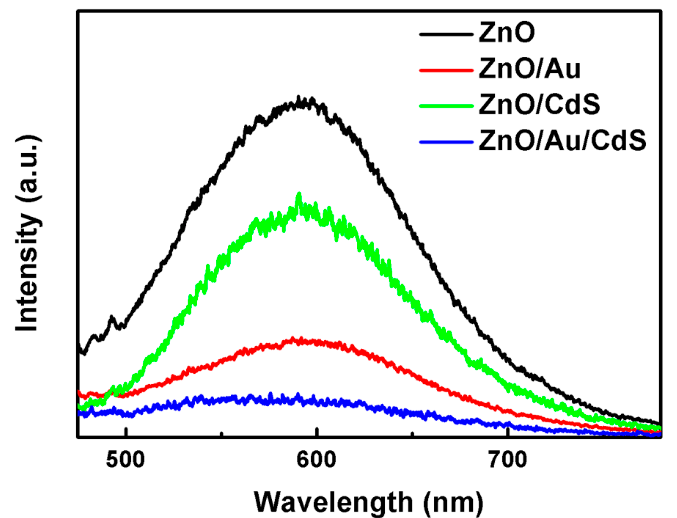
Figure 7. Photoluminescence (PL) spectra of ZnO, ZnO/Au, ZnO/CdS and ZnO/Au/CdS samples. The ZnO, ZnO/Au, ZnO/CdS and ZnO/Au/CdS samples are used for photocatalytic water splitting for H 2 evolution. As shown in Figure 8a, both ZnO and ZnO/Au samples present low gas evolution rates of 22.3 and 33.5 µ mol/g/h, respectively. The ZnO/CdS sample shows a much higher gas evolution rate of 346.0 µ mol/g/h, which can be ascribed to the formation of type II heterojunction structure and the extension of light absorption range. After the introduction of Au nanoparticles into the ZnO/CdS system, the ZnO/Au/CdS ternary composite photocatalyst sample shows a remarkably improved photocatalytic performance with a gas evolution rate of 502.2 µ mol/g/h, which is about 1.5 times than that of ZnO/CdS sample. The results suggest that the Au and CdS nanoparticles have a synergistic effect for the improvement of photocatalytic water splitting. Meanwhile, in order to prove the stability of the ZnO/Au/CdS ternary composite photocatalyst, the cycling stability measurement is conducted. As shown in Figure 8b, the amounts of gas evolution maintain for four cycles with slight decay and the slight decrease in photocatalytic activity is attributed to the ZnO photocorrosion phenomena [23,53]. The above results indicate that the actinomorphic flower-like ZnO/Au/CdS ternary composite material is a promising photocatalyst for water splitting.